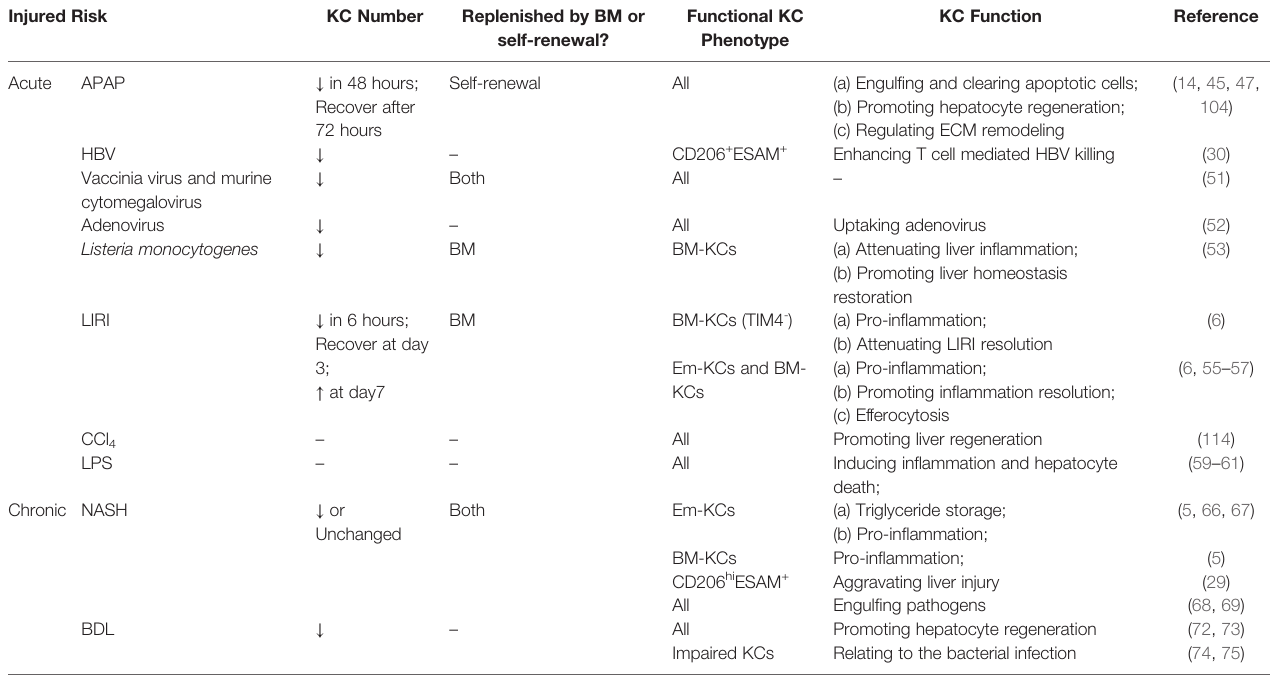
TABLE 2 | KC heterogeneity and function in Liver injury. Injured